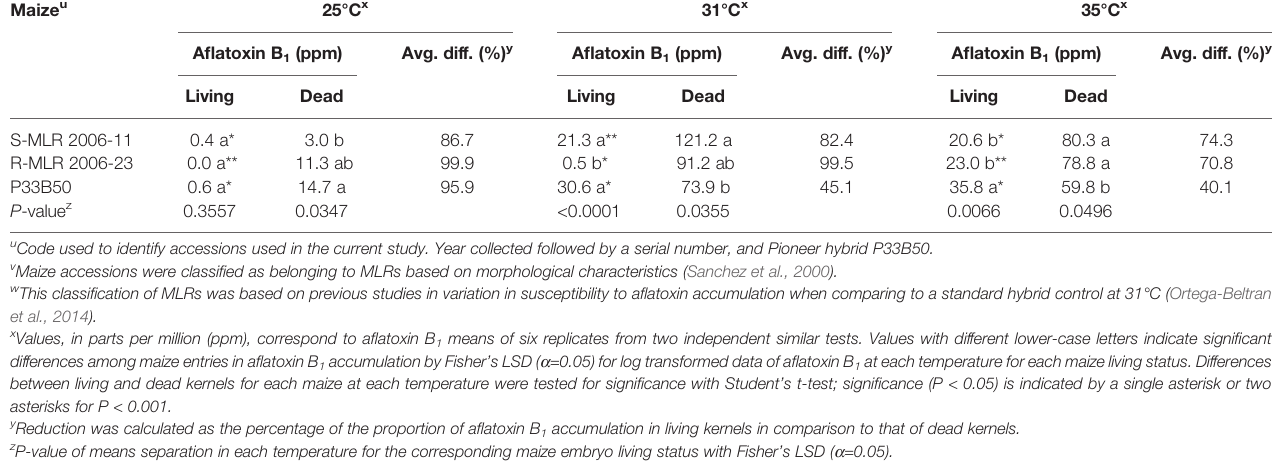
TABLE 4 | Comparison of a fl atoxin B 1 production by Aspergillus fl avus SSS06 MN-F in living versus dead kernels of two native maize landrace (MLR) accessions and a commercial hybrid at three different temperatures. Maize u 25°C